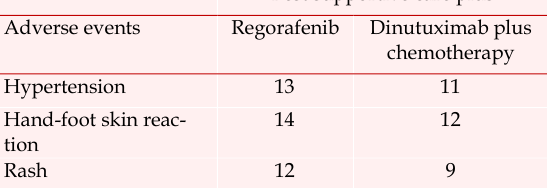
Comparison of treatment-related adverse events in children with neuroblastoma (safety population) Best supportive care plus